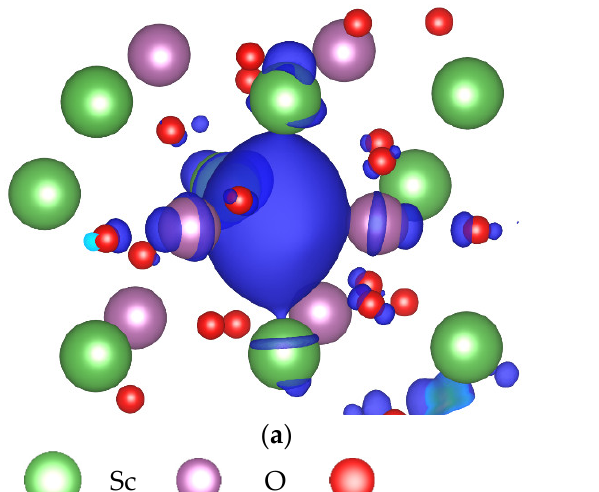
Figure 4. Orbital-projected electron density of F 0 -, F + - and F ++ -centres ( a ) and electron holes on oxy- gen p -orbitals ( b ).